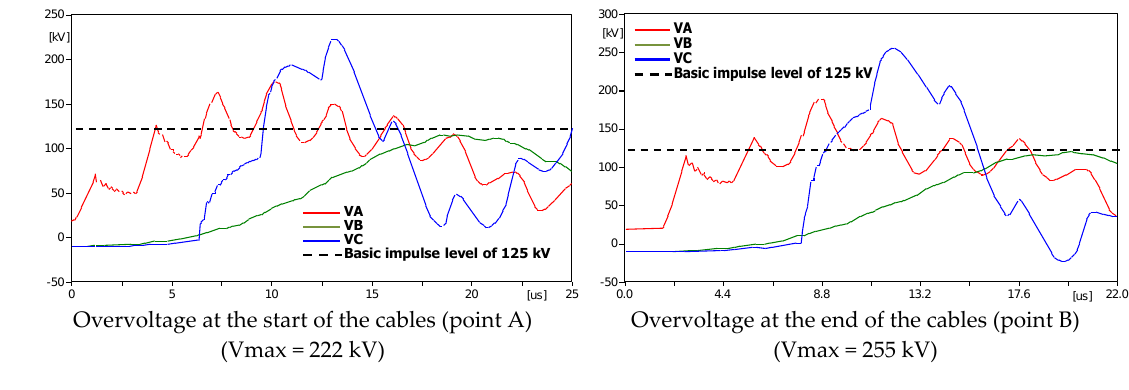
(Vmax = 274 kV) Figure 28. A 100 m underground cable.